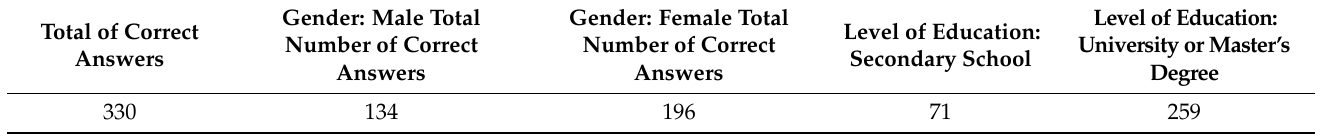
Figure 4. Posttest 1 control group, and Posttest 1 prepositions and means. Table 6. Pretest results regarding gender and level of